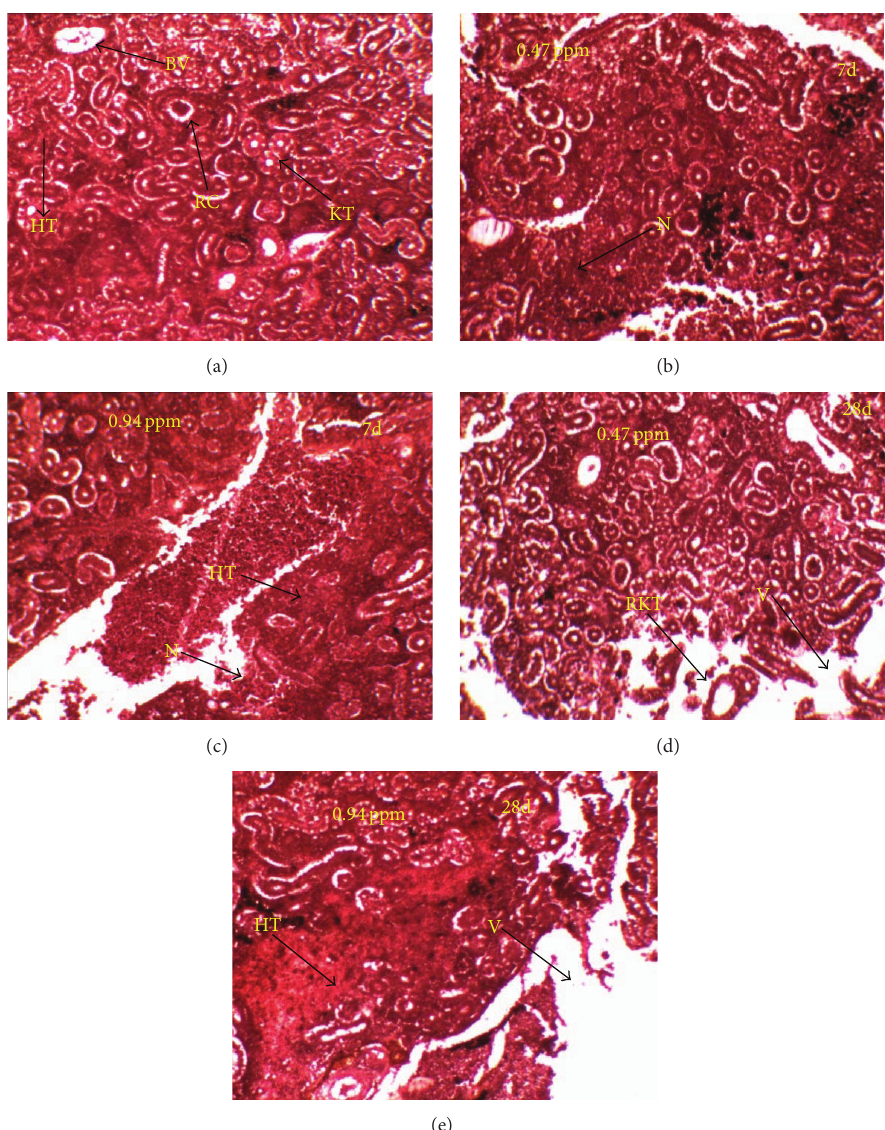
Figure 3: Histoarchitectural changes in kidney (H & E stained, × 100) exposed to QP (a) control, (b) and (d) 0.47 ppm at 7 and 28 days, and (c) and (e) 0.94 ppm at 7 and 28 days. Arrows are indicating blood vessel (BV), hematopoietic tissue (HT), kidney tubules (KT), necrosis (N), renal corpuscle (RC), ruptured kidney tubules (RKT), and vacuolation